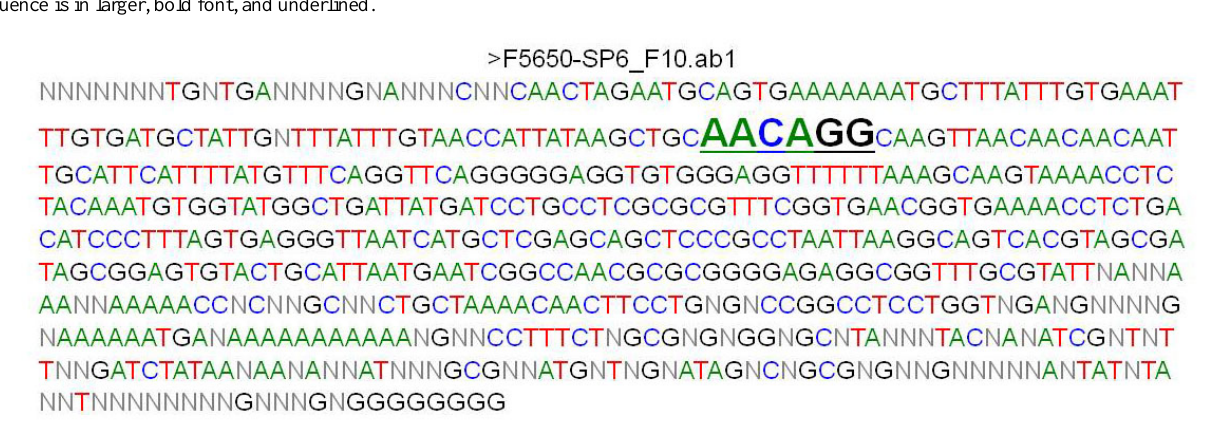
Figure 3. Sequencing data for clone F. Sequencing of F clone target polyA site; PCR product sequencing from genomic DNA. Relevant AACAGG sequence is in larger, bold font, and